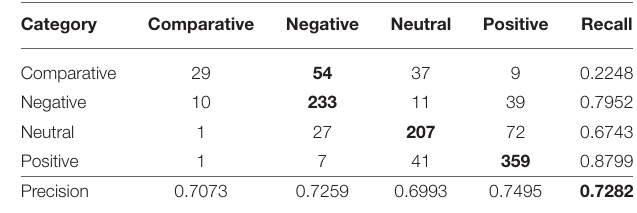
TABLE 11 | Confusion matrix for the fasttext classifier for the tweets. Category